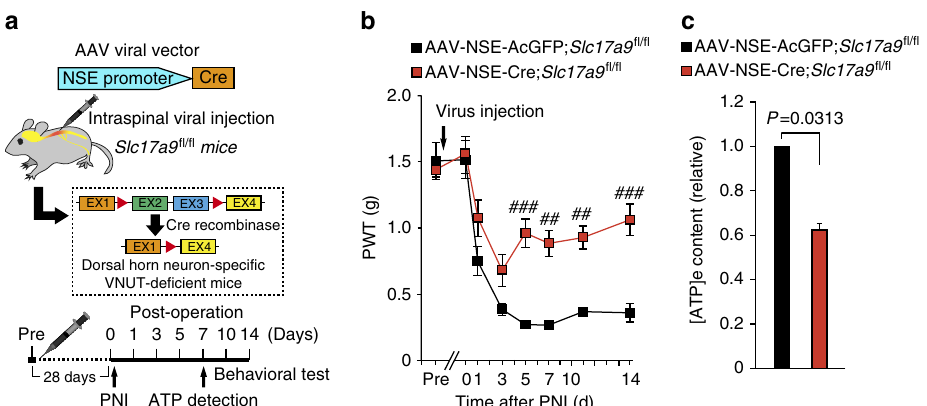
Figure 6 | VNUT expressed in SDH neurons is required for increased spinal extracellular ATP and pain hypersensitivity after PNI. ( a ) Schematic diagram of the experimental protocol. ( b ) PWT of Slc17a9 fl/fl mice intraspinally injected with AAV-NSE-AcGFP or AAV-NSE-Cre viral vectors before and after PNI (AAV-NSE-AcGFP: n ¼ 5, AAV-NSE-Cre: n ¼ 8; ## P o 0.01, ### P o 0.001 versus AAV-NSE-AcGFP; Slc17a9 fl/fl , two-way ANOVA with post hoc Bonferroni test). ( c ) Measurement of [ATP] e content in the ACSF media of spinal cord slices isolated from Slc17a9 fl/fl mice intraspinally injected with AAV-